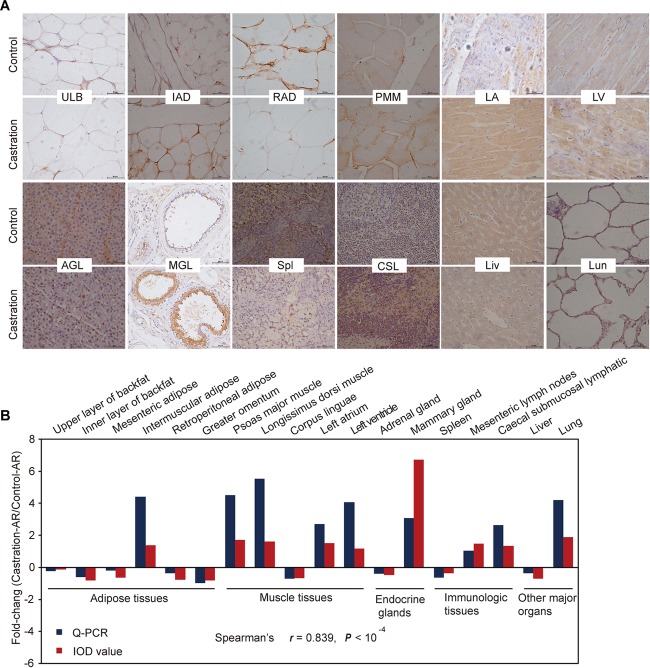
Immunohistochemical and correlation analysis between immunohistochemical staining and qRT-PCR results of AR. (A) Immunohistochemical analysis for 12 representative tissues using an AR (C-19) antibody. Scale bars: 50 μm; 400× magnification. ULB, upper layer of backfat; IAD, intermuscular adipose; RAD, retroperitoneal adipose; PMM, psoas major muscle; LA, left atrium; LV, left ventricle; AGL, adrenal gland; MGL, mammary gland; Spl, spleen; CSL, caecal submucosal lymphatic; Lun, lung; Liv, liver. (B) Fold change of AR mRNA expression in all tissues based on Spearman’s rank correlation. The relative expression levels were measured by qRT-PCR and IOD. n = 4 in each group.